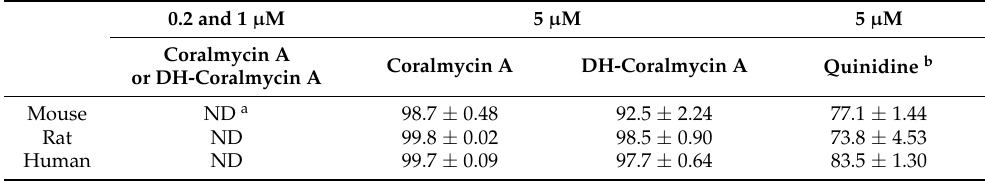
Table 3. Plasma protein-binding ratio (%) of coralmycins (mean ± SD, n =